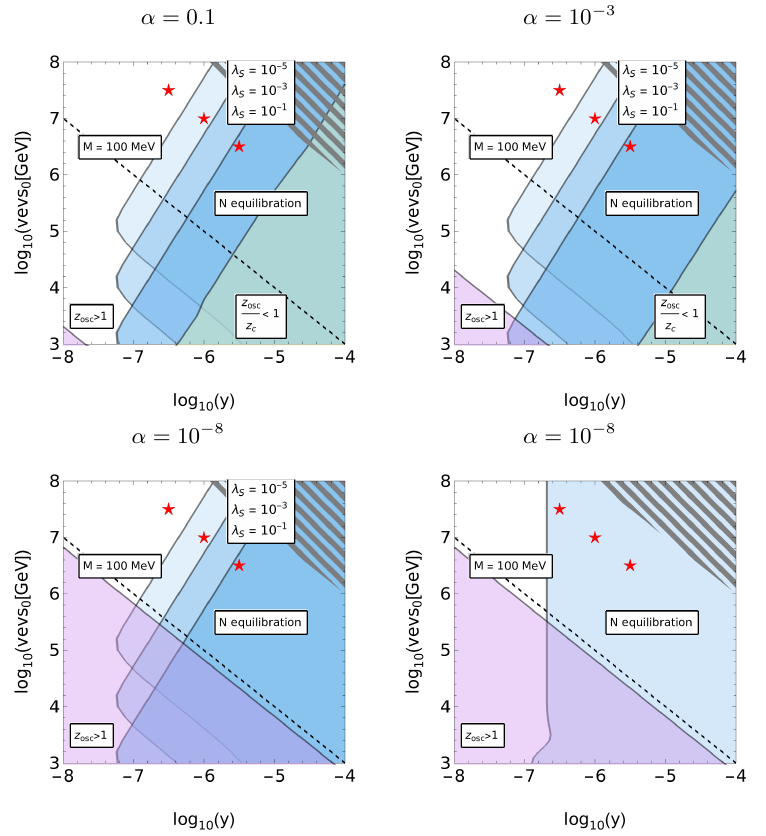
Figure 2. Parameter space with limits from successful leptogenesis as discussed in the text, in the projection v 0 and Y . Areas where the process ( a ) ( S → NN ) starts thermalising the sterile S neutrinos are shown by the blue color, considering λ S = 10 − 1 , 10 − 3 10 − 5 . Areas where the active- sterile oscillations occur after Sphaleron freeze-out are shown by the pink color. The green area denotes where z S > z osc . The black hashed corner indicates sterile neutrino masses M N ≥ 100 GeV, and the dashed line corresponds to M N = 0 . 1 GeV. Plotted are the benchmark points A, C and D, cf. table 2. For the lower right panel, M 0 = 10 TeV was fixed. Throughout, λ SH = 10 − 3 is fixed. S Time of scalar symmetry